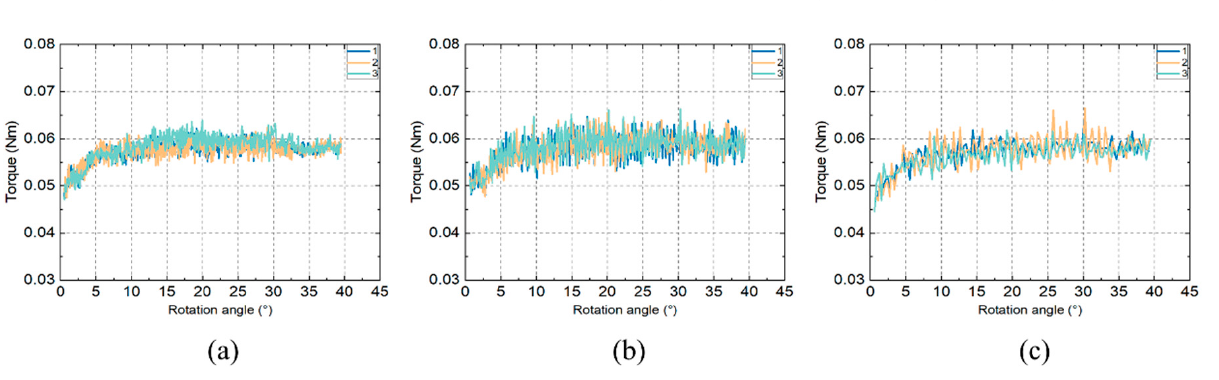
The three repeated torque rotation angle data points at 5 dps were firstly averaged, and then the data in the region of 5 to 40 degrees were selected and fitted with a linear